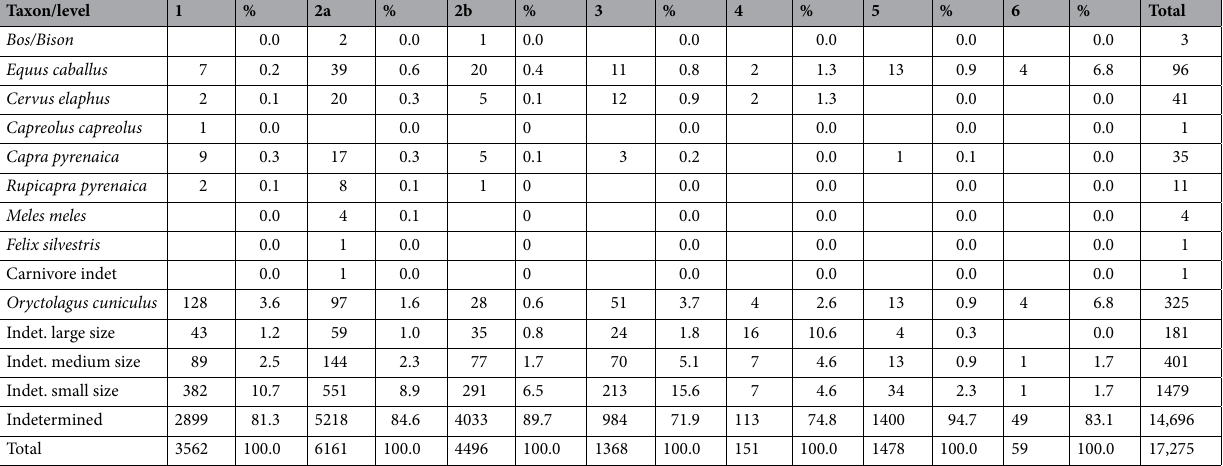
Table 4. Taxonomic representation of macrovertebrates remains at the Peña Capón sequence.